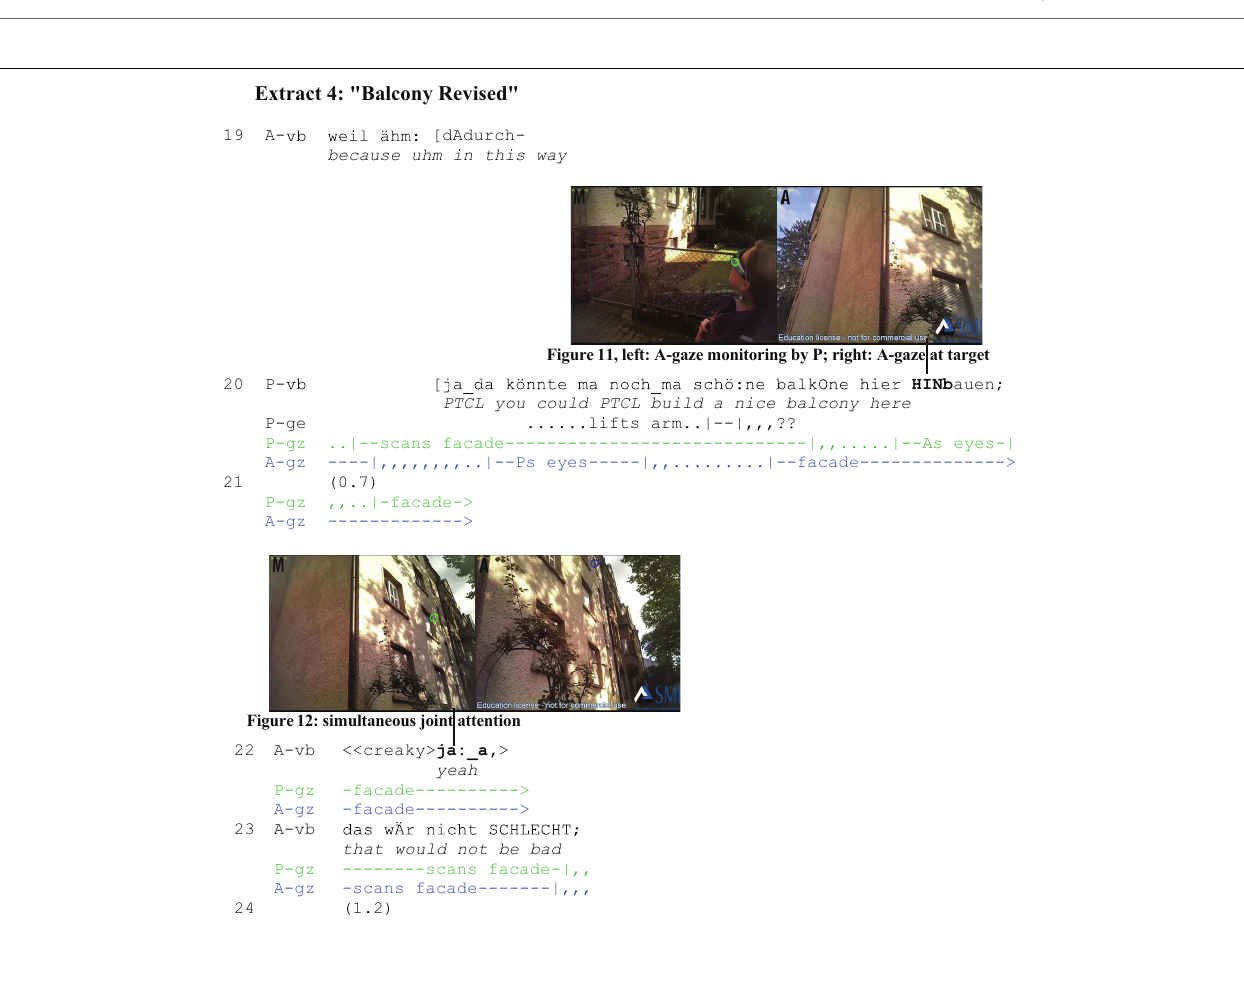
Figure 12: simultaneous joint